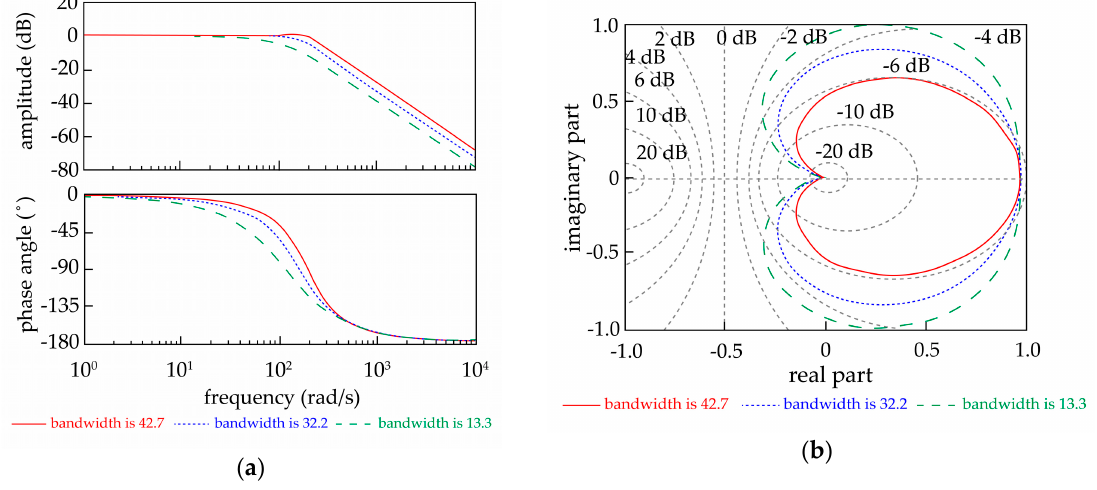
Figure 13. Parameters design of the voltage loop. ( a ) The bode diagram of the voltage loop; ( b ) the Nyquist curve of the voltage loop.